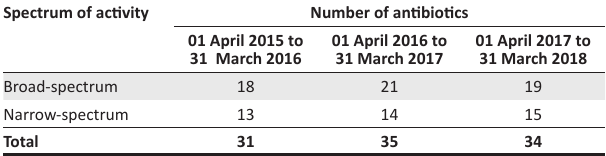
TABLE 5: Antibiotic spectrum of activity between 01 April 2015 and 31 March 2018.